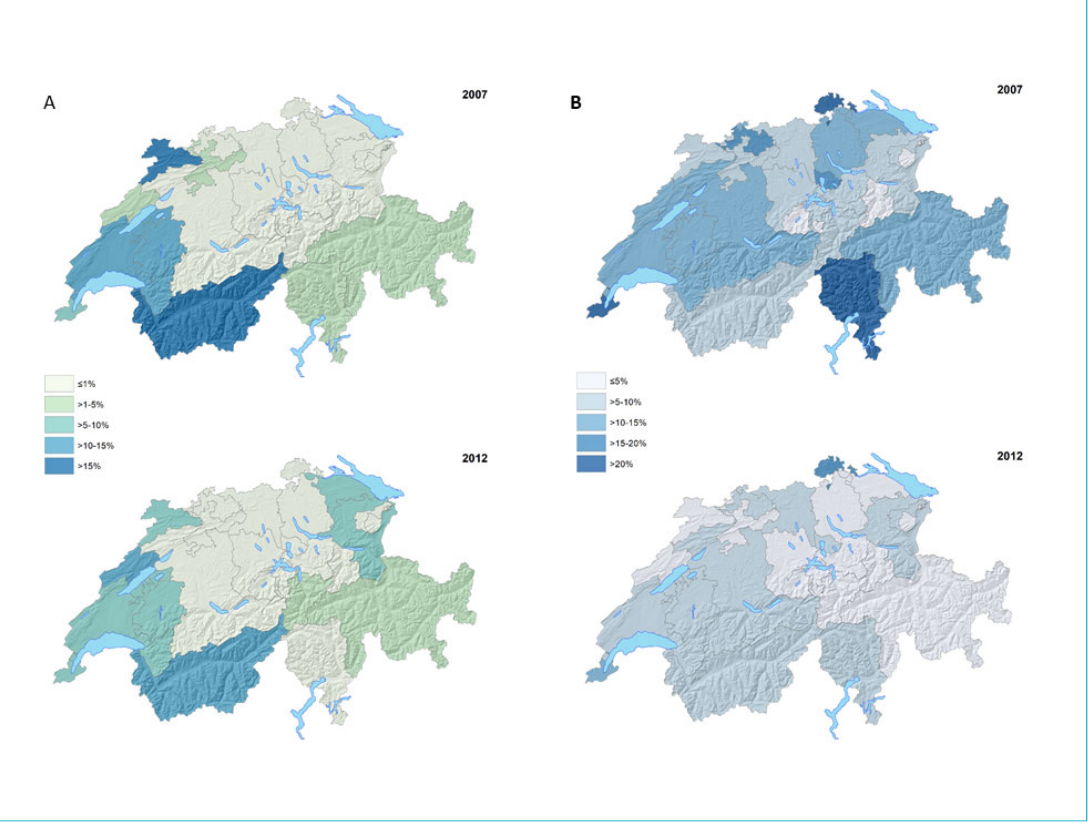
Figure S2: Geographical distribution of self-reported mammography in the last 12 months in women aged 40–79 years in Switzerland, 2007 and 2012. A. Programmatic mammography within a systematic cancer screening programme). B. Opportunistic mammography (screening mammography without clinical